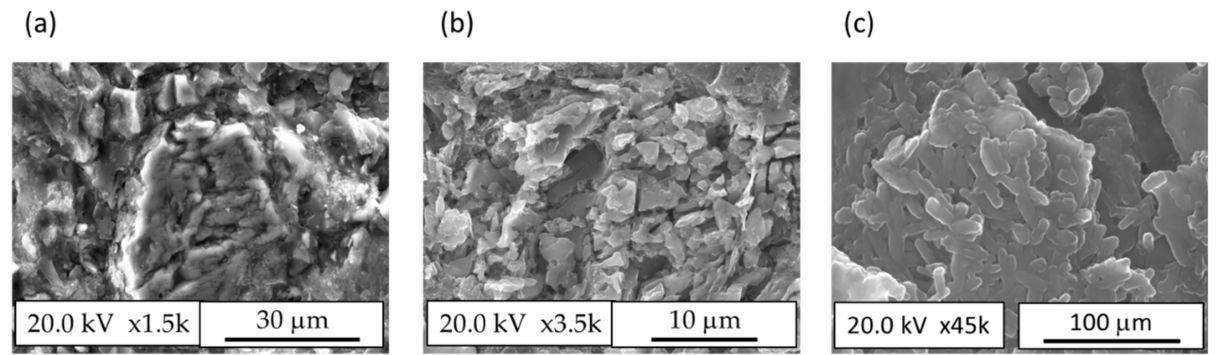
Figure 11. Microstructure FESEM images taken at different regions of 100% clay B. ( a ) The FESEM images of different regions observed in the microstructure of 100% clay B brick; ( b ) The high potassium ox-ide content area in ceramic matrix; ( c ) FESEM observations at high